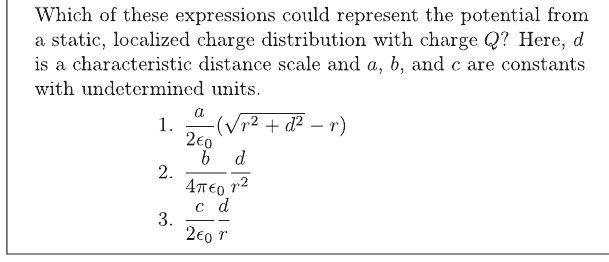
target reflection. Students must determine the units of a , b , and c .